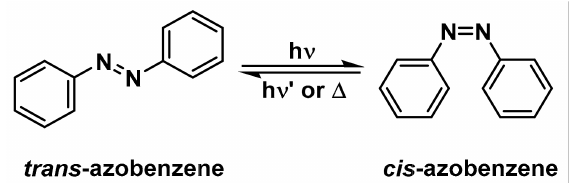
Figure 1. Reversible photoisomerization of azobenzene in two